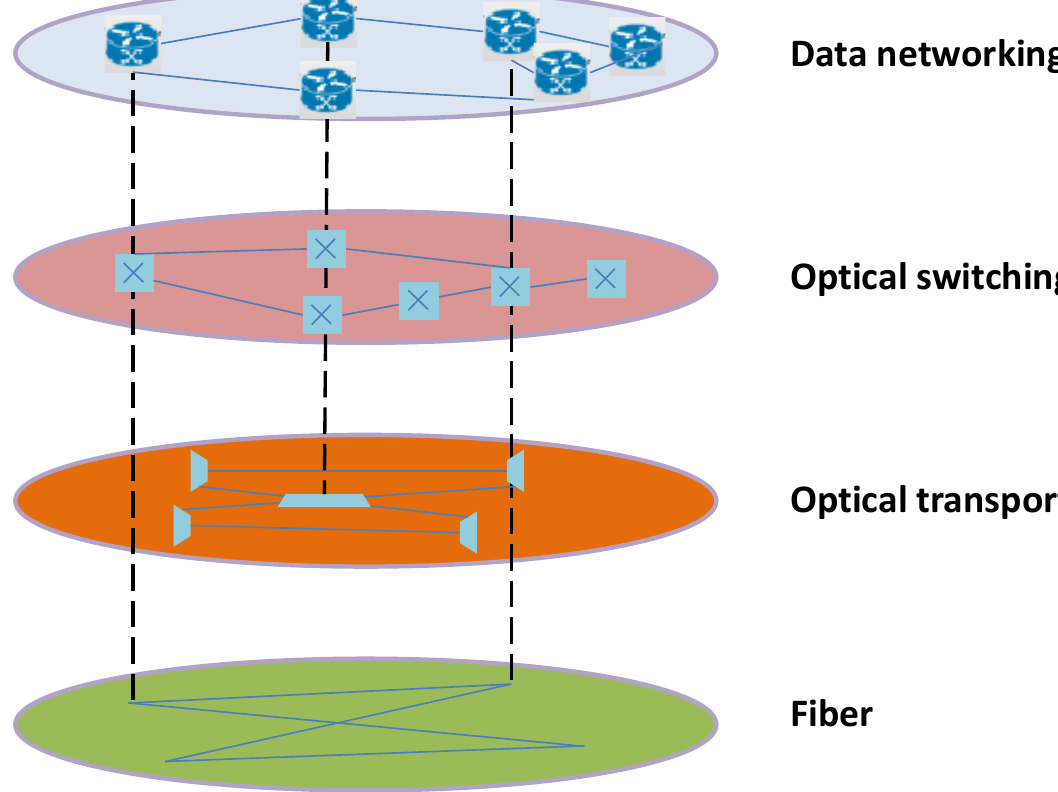
Figure 26. Data networking over all-optical infrastructure (IP over optical networks).